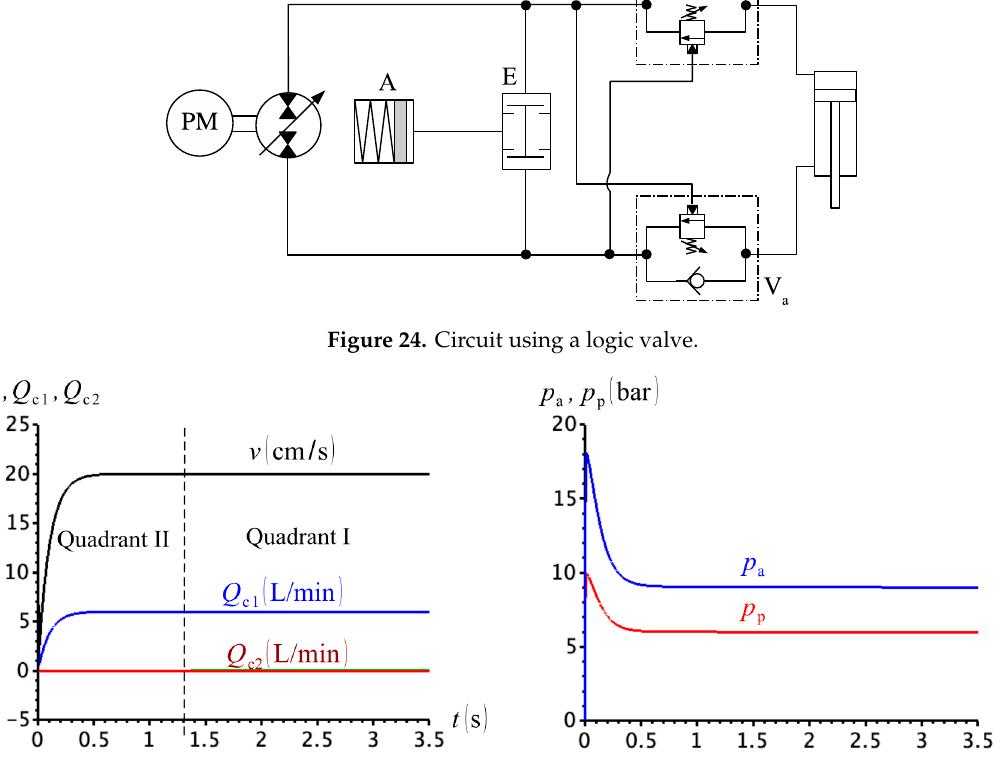
Figure 25. ( a ) Cylinder velocity and compensation valve flows; ( b ) cap- and rod-side pressures ( m = 0.5 kg and p cr = 1.0 × 10 − 6 bar).